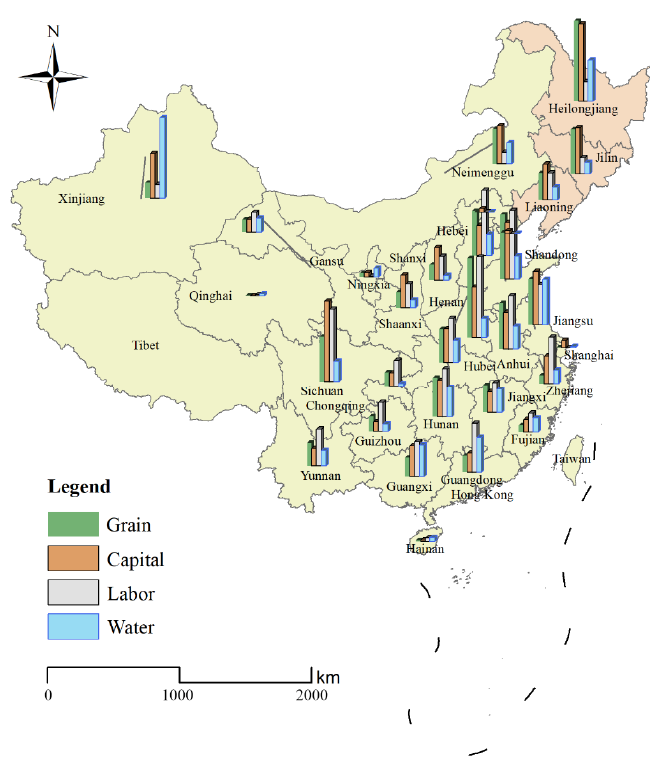
Figure 3. Grain production in different provinces, as well as capital, labor, and water inputs.